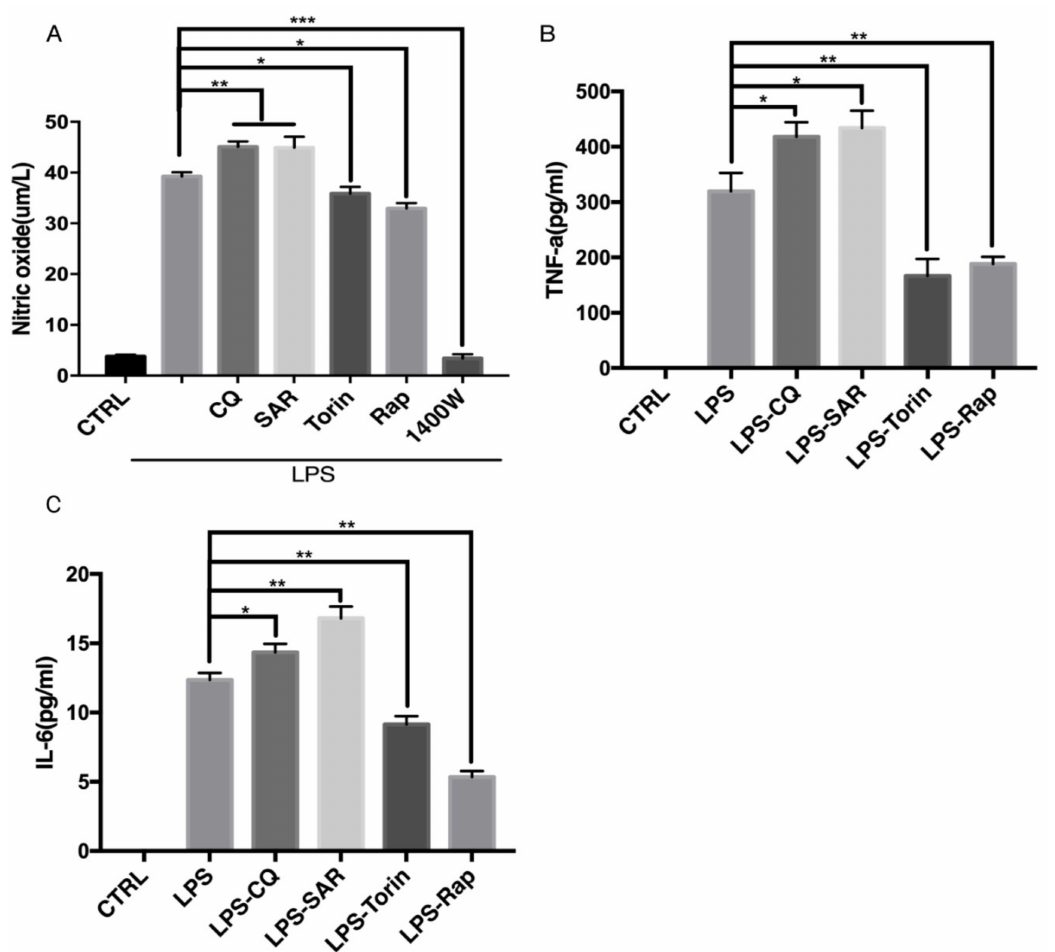
Figure 5. Regulation of autophagy a ff ects NO production and inflammatory cytokines release. Raw 264.7 cells were treated with LPS (200 ng / mL) 12 h, followed by removing LPS and add CQ (30 µ M), SAR (1 µ M), Torin (1 µ M), Rap (1 µ M) 1400 w (100 µ M) for another 12 h. ( A ) Detection of nitric oxide level from Raw 264.7 cells by Griess assay. ( B ) Detection of TNF- α level by ELISA assay ( C ) Detection of IL-6 level by ELISA assay. ( A – C ) CTRL group is blank control group with DMSO treatment. The results were analyzed from three individual experiments by GraphPad Prism, each experiment conducted three times. * p < 0.05, ** p < 0.01, *** p < 0.001. Error bars (mean ± SEM). One-way ANOVA with post hoc